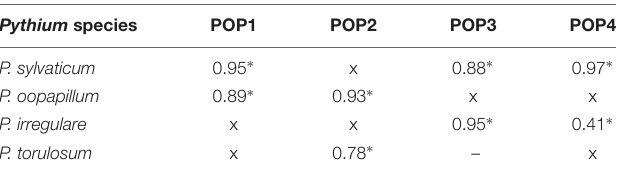
TABLE 2 | Summary of Pearson correlation coefficients within all four populations for both disease reaction traits, seed rot severity (SRS), and percent of rotted seeds in inoculated plates (ROTS), for all Pythium species tested, P. sylvaticum , P. irregulare, P. oopapillum , and P. torulosum . Pythium species POP1 POP2